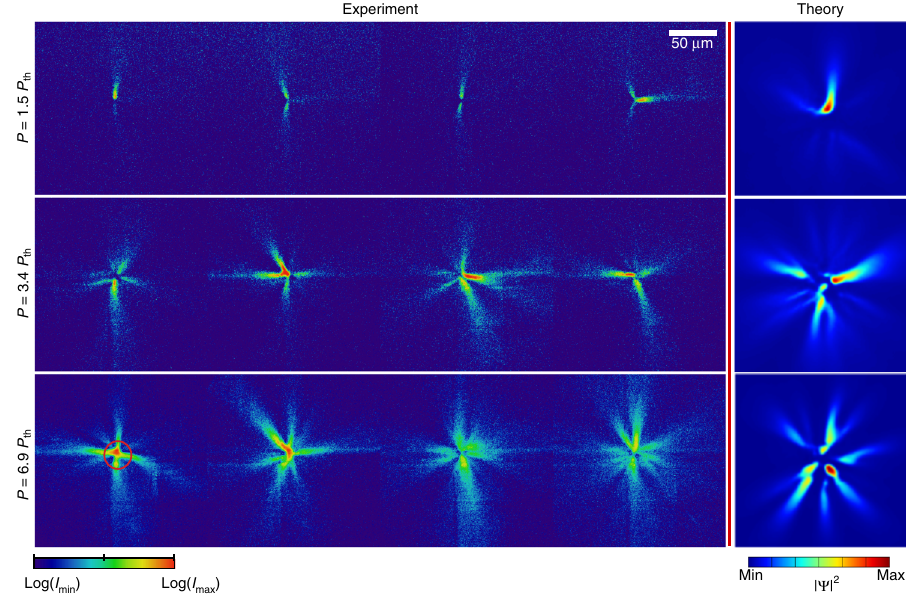
Fig. 2 Single-shot condensation of photonic polaritons. The panels show single-shot real space images of the photoluminescence intensity (proportional to polariton density) above condensation threshold P th ≈ 10 mW, in the far red-detuned (large negative detuning, Δ = − 22 meV) regime for various pump powers. The circle indicates approximate location of the pump. Each panel represents a single realisation of a spontaneous condensation process. The intensity is plotted on a log scale for the experimental images to elucidate the details of regions with low density emission. The theory column shows polariton density obtained by numerical